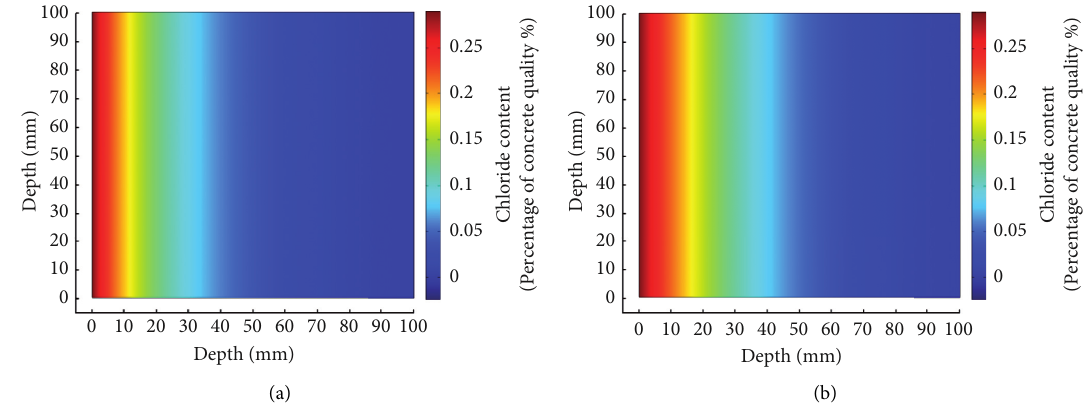
Figure 13: Comparison of chloride coupling migration and pure diffusion in chloride transport model: (a) coupled moisture desorption, saturation 0.6; (b) pure diffusion, saturation